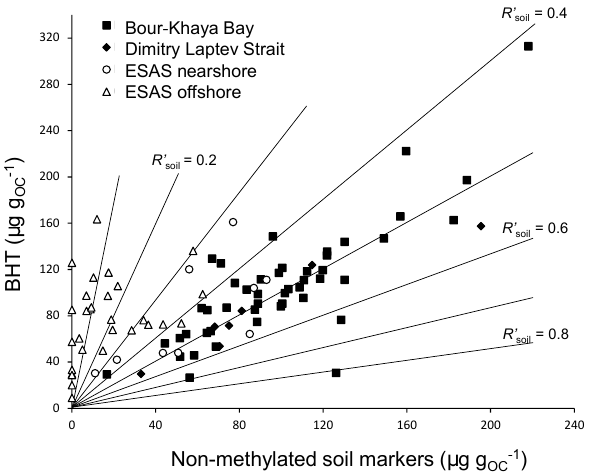
Figure 4. Plot of the concentrations (µgg − 1 methylated soil markers grouped according to sampling location in Buor-Khaya Bay, Dmitry Laptev Strait, ESAS nearshore and off- shore. Labelled contours show the R (cid:48) soil index values.